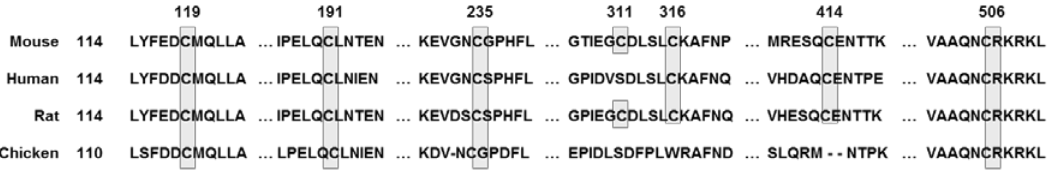
Figure 3. Domain structures and functional domains of Nrf2. The Nrf2 protein contains 7 domains, Neh1-7. The N-terminal Nrf2-ECH homology (Neh) 2 domain has ETGE and DLG motifs that bind to the Kelch domain of Kelch-like ECH-associ- ated protein 1 (KEAP1), resulting in Cullin 3 (Cul3)-dependent E3 ubiquitination and proteasome degradation. The Neh4 and Neh5 domains mediate the transactivation activity of Nrf2. The Neh7 domain inhibits transcription of the Nrf2 target gene. The Neh6 domain has DSGIS and DSAPGS motif. The Neh1 domain helps Nrf2 dimerization with DNA binding to other transcription factors. The C-terminal Neh3 domain supports the Nrf2 transcriptional activity. Adapted from Ooi et al. [57]. NH 2 ; N-terminal, COOH; C-terminal, RXR α ; retinoed X receptor-alpha, β -TrCP; beta-transducin repeat containing E3 ubiquitin protein ligase, ARE; antioxidant response element, CDH6; chromo-ATPase/helicase DNA-binding protein 6. 3.2. KEAP1 KEAP1 was identified as a negative regulator of Nrf2 in 1999 by Itoh and his col- leagues [45]. KEAP1 has three major domains, including the Broad com- plex/Tramtrack/Bric-a-brac (BTB) domain, the intervening region (IVR) domain, and the Kelch domain, also called the double glycine repeat (DGR) domain (Figure 4). The BTB domain resides at the N-terminal, binds to Cul3, and forms homologs and dimers [58]. The IVR domain connects the BTB domain and the Kelch domain and is rich in cysteine residues essential for KEAP1 activity [44,59]. The Kelch domain has six conserved Kelch repeat sequences in the C-terminal domain [60], which also interacts with the Neh2 do- main of Nrf2 and plays an important role in the interaction of KEAP1 and Nrf2 [45]. KEAP1 is a very cysteine-rich protein, with 25 mouse and 27 human cysteine residues [60]. KEAP1 has several cysteine sensors, especially the C151, C273, and C288 cysteine sensors, which have been found to induce Nrf2 into the nucleus and the expression of target genes by modifying the structure of KEAP1 by oxidizing agents and electrophiles [61]. Many plant-derived affinity electronic substances are known to induce a cytoprotective re- sponse by activating the Nrf2-KEAP1 axis, in which case the cysteine residue of KEAP1 has been found to act as a sensor [62,63]. Therefore, KEAP1 is considered a biosensor of electrophiles and ROS [64].